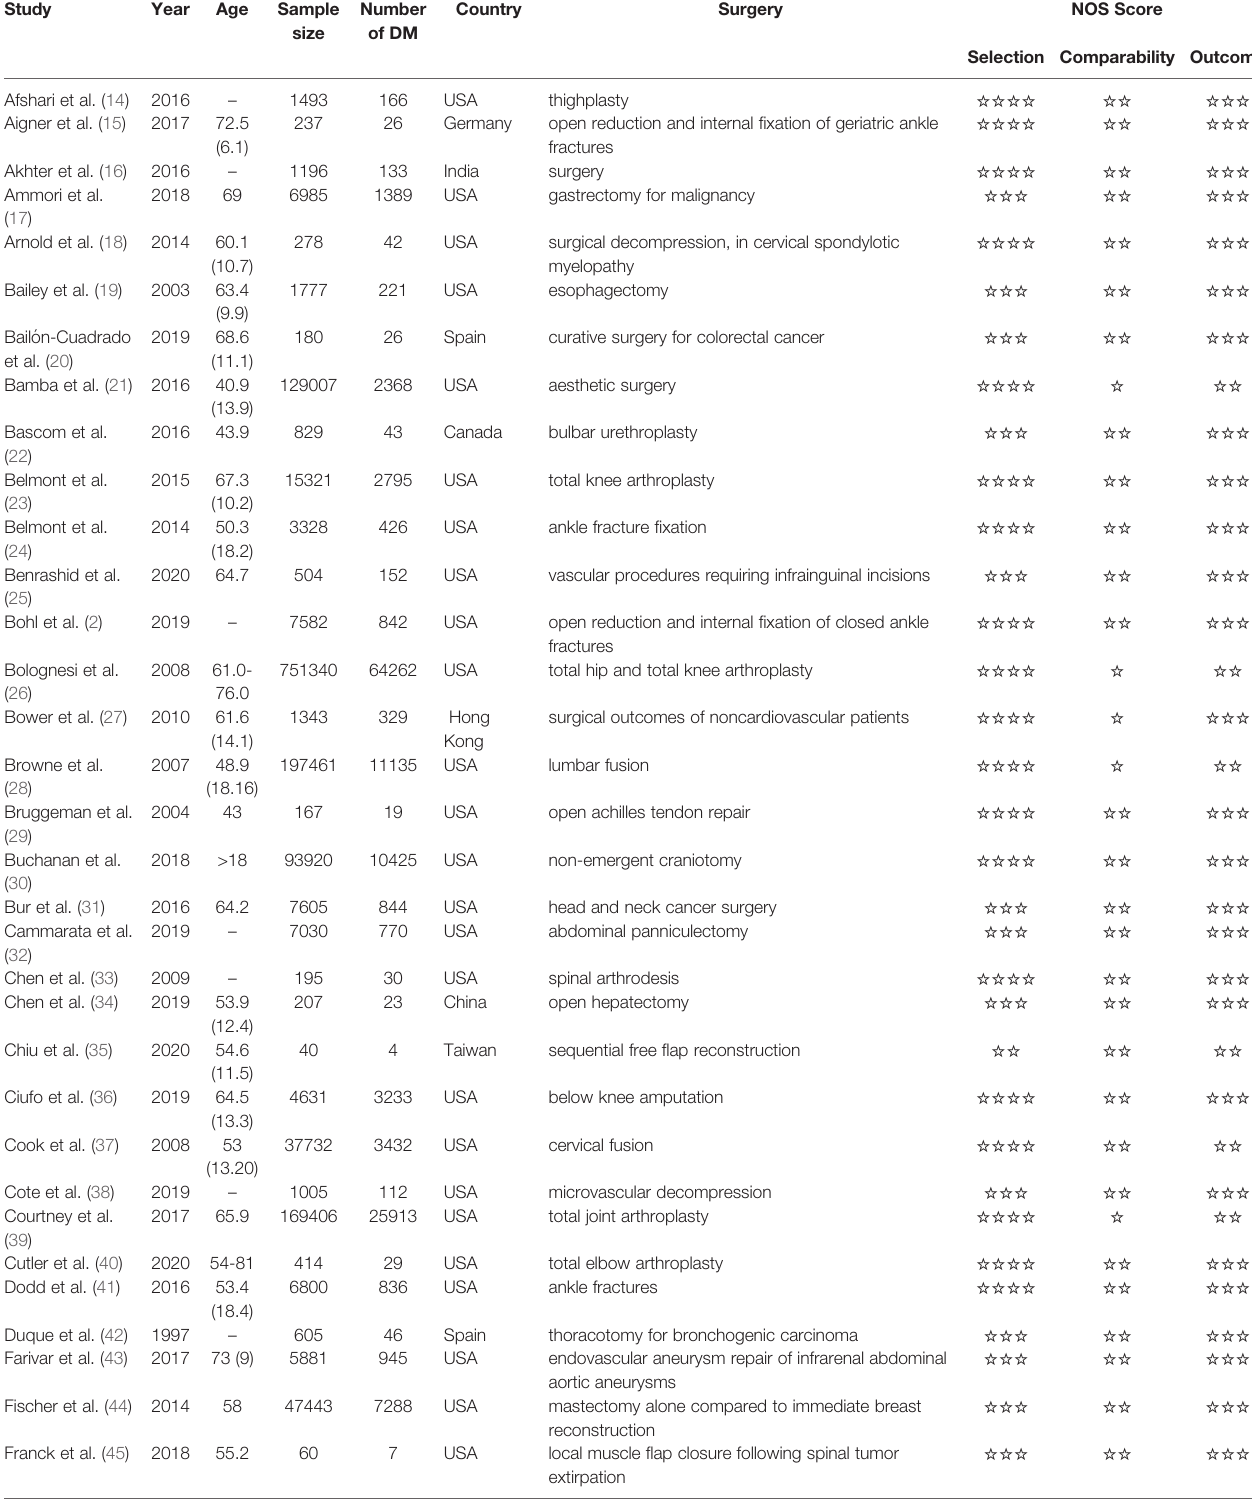
TABLE 1 | Characteristics of included